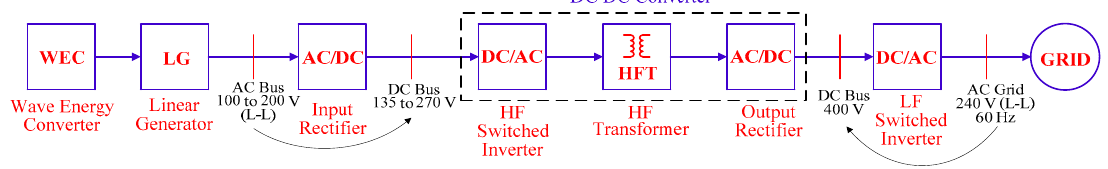
Figure 2. Block diagram of grid integration of a wave-energy plant [24].